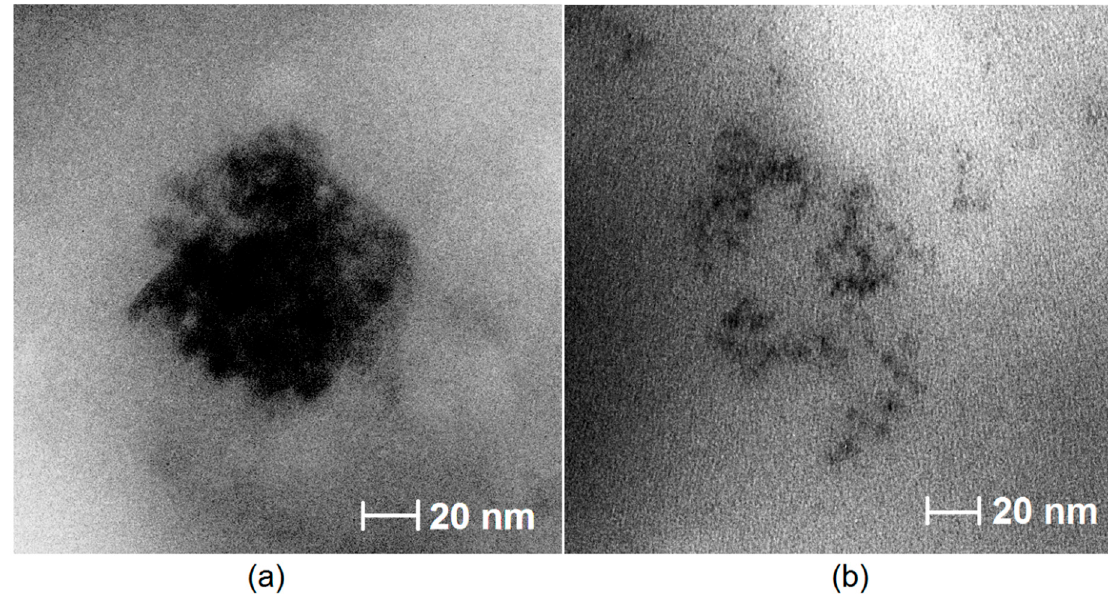
Figure 6. TEM images of the prepared CQDs: ( a ) CQDs-4; ( b ) CQDs-6.